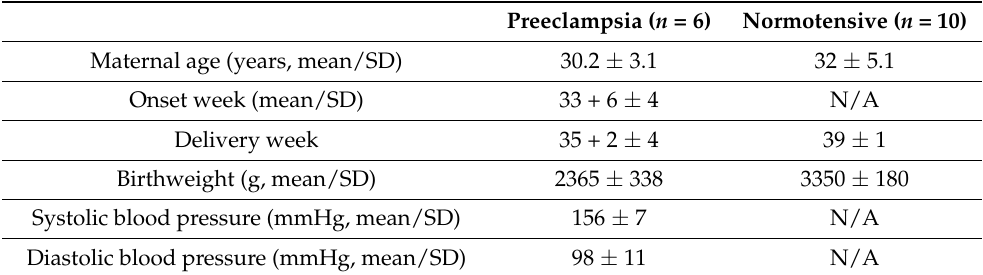
Table 1. Clinical parameters of the study